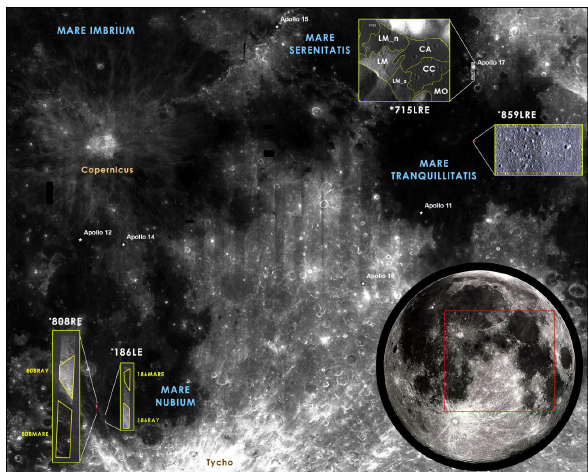
Figure 1. Locations of areas under investigation. NAC